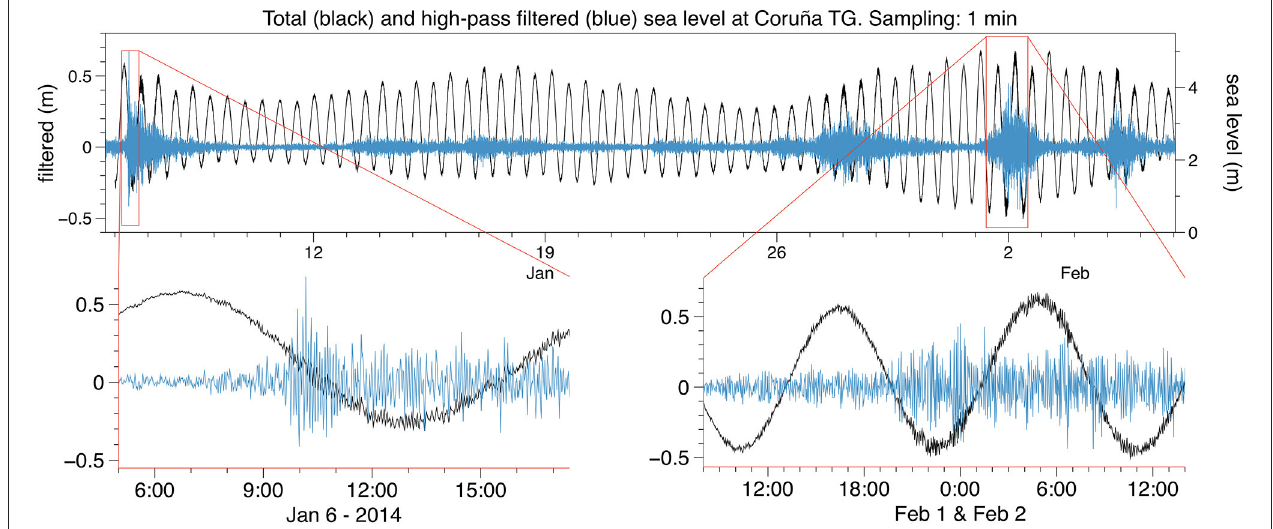
FIGURE 5 | Total sea level (black) and high-pass filtered signal (blue) recorded by Coruña tide gauge for January–February 2014; data sampling: 1min. The two most extreme events (January 6th and February 2nd) are shown amplified below. The maximum amplitude of the oscillation does not occur during high-tide, especially on January